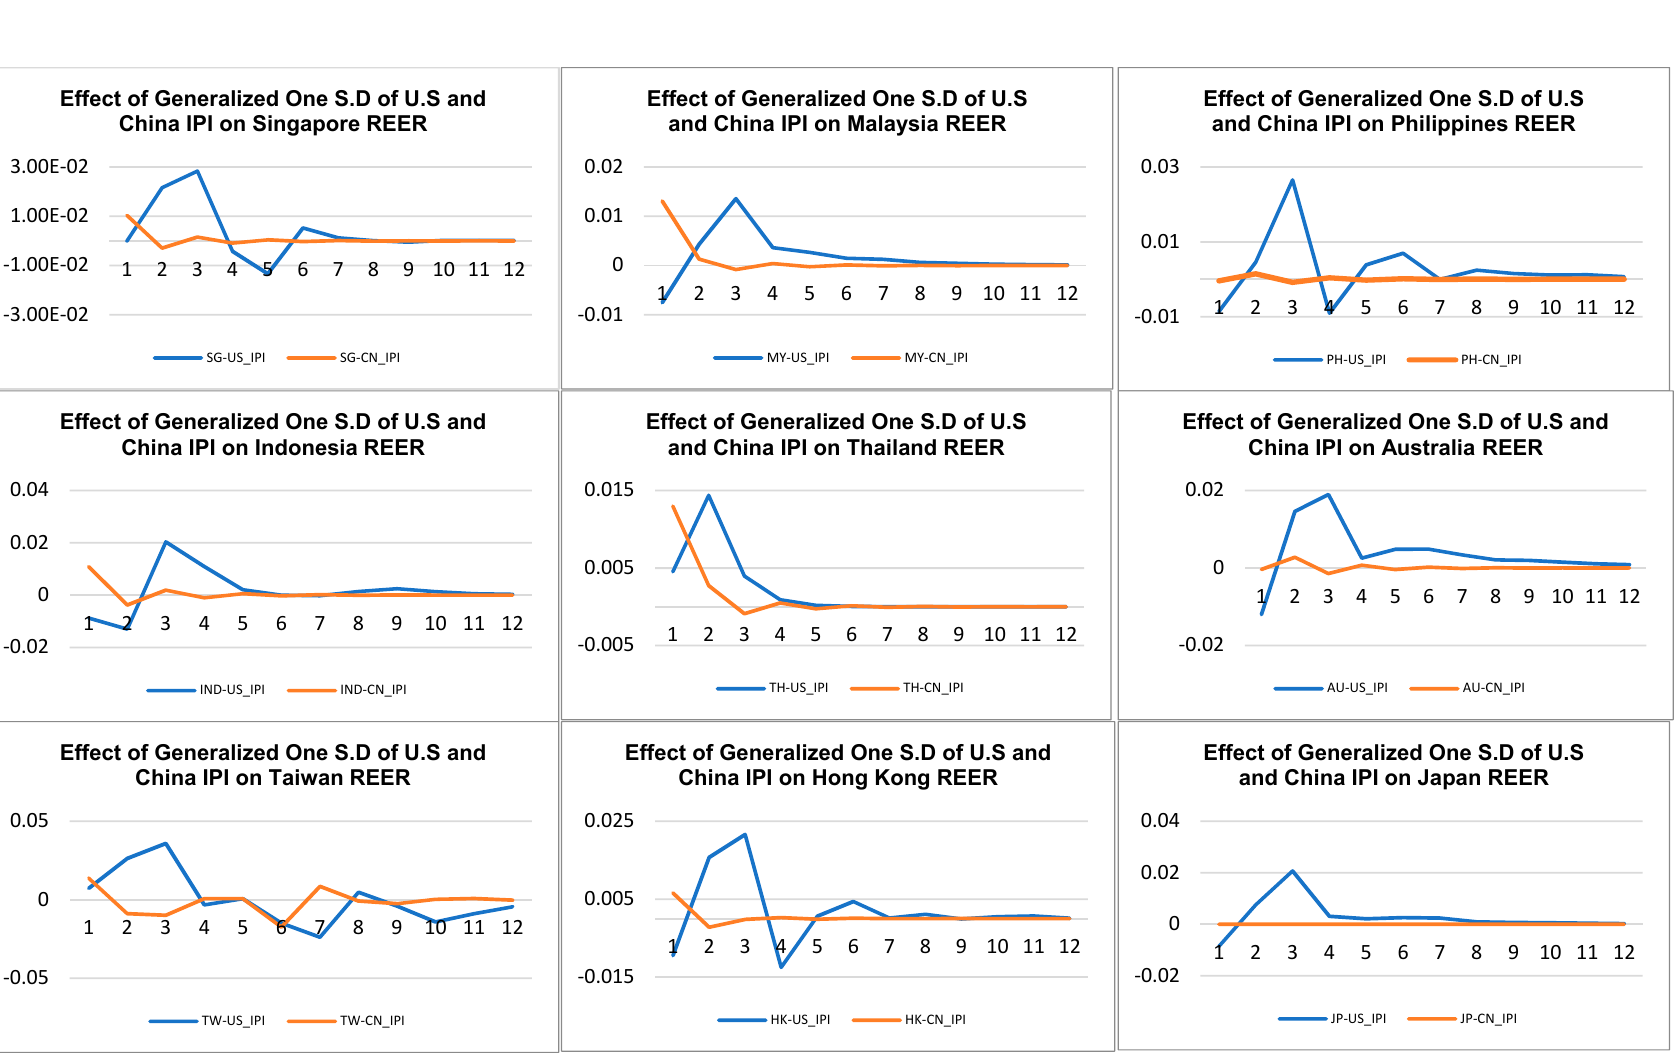
Figure 2. VAR estimations of Impact of Innovations of one standard deviation in US and China industrial production index (IPI) on the APAC REERs.